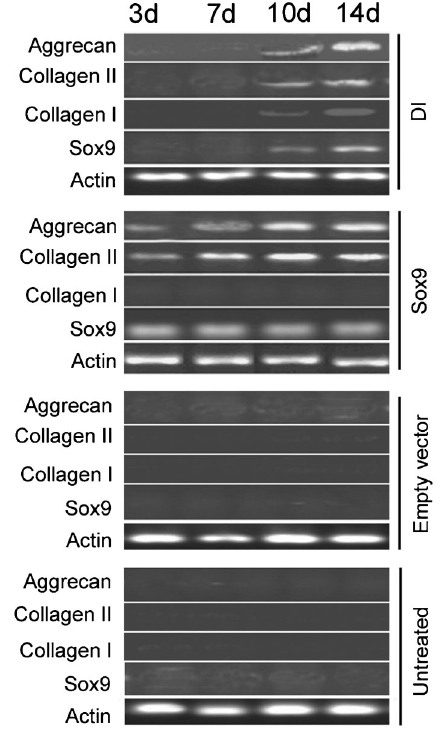
Figure 3. RT-PCR analysis of the mRNA expression of Sox9, collagen I, collagen II, and aggrecan in untreated hUC-MSCs cells and those transfected with empty vector or Sox9-expressing plasmid or induced with the chondrogenic medium (differentia- tion-induced group: DI). Representative gel photographs of RT- PCR products from three independent experiments are shown. d: days.